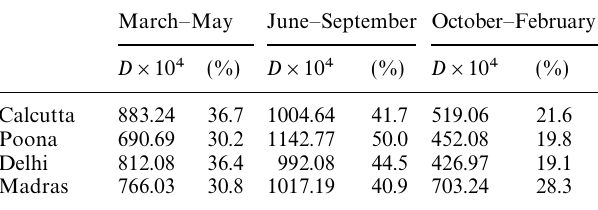
Table 4. Values of mean daily diffuse solar radiation (in J · m (cid:126)(cid:50) · day (cid:126)(cid:49) ) during the premonsoon (March — May), monsoon (June — September) and postmonsoon (October — February) seasons with their annual